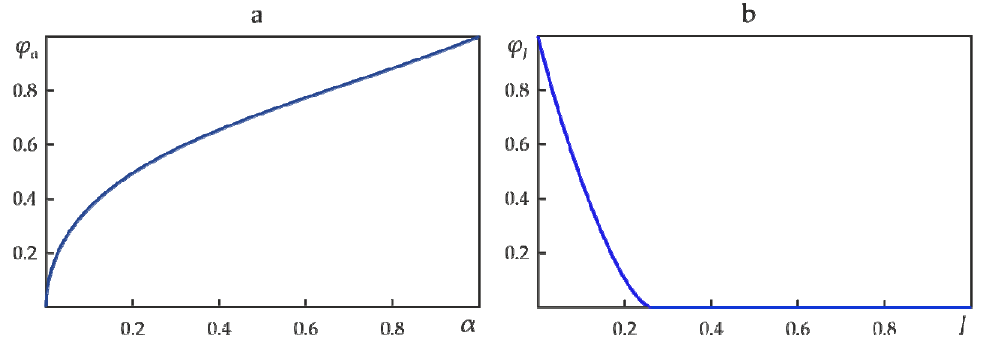
Figure 7. Membership functions ( a ) “injected water losses should not be large”, ( b ) “the deviation of the calculated reservoir pressure from the actual one should not be